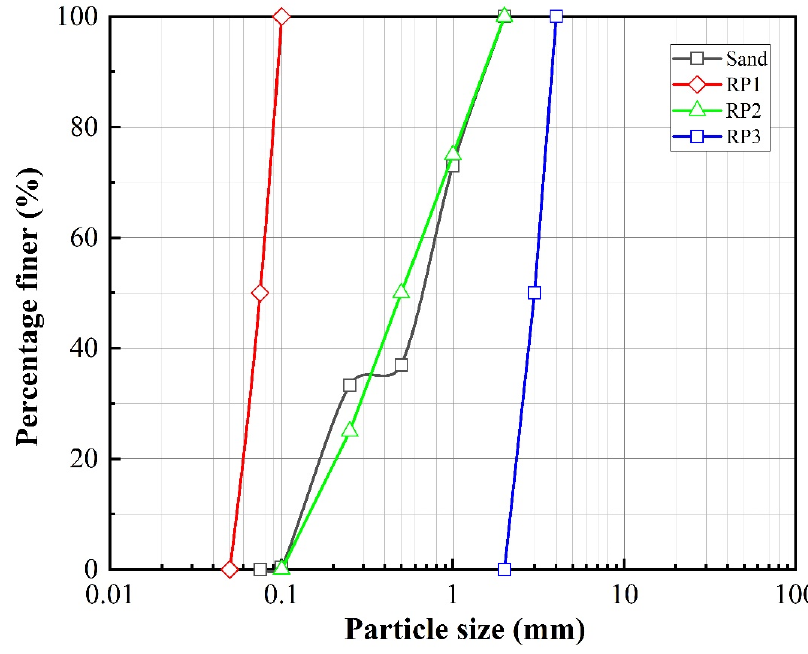
Figure 1. The particle size distribution curves of the tested materials.